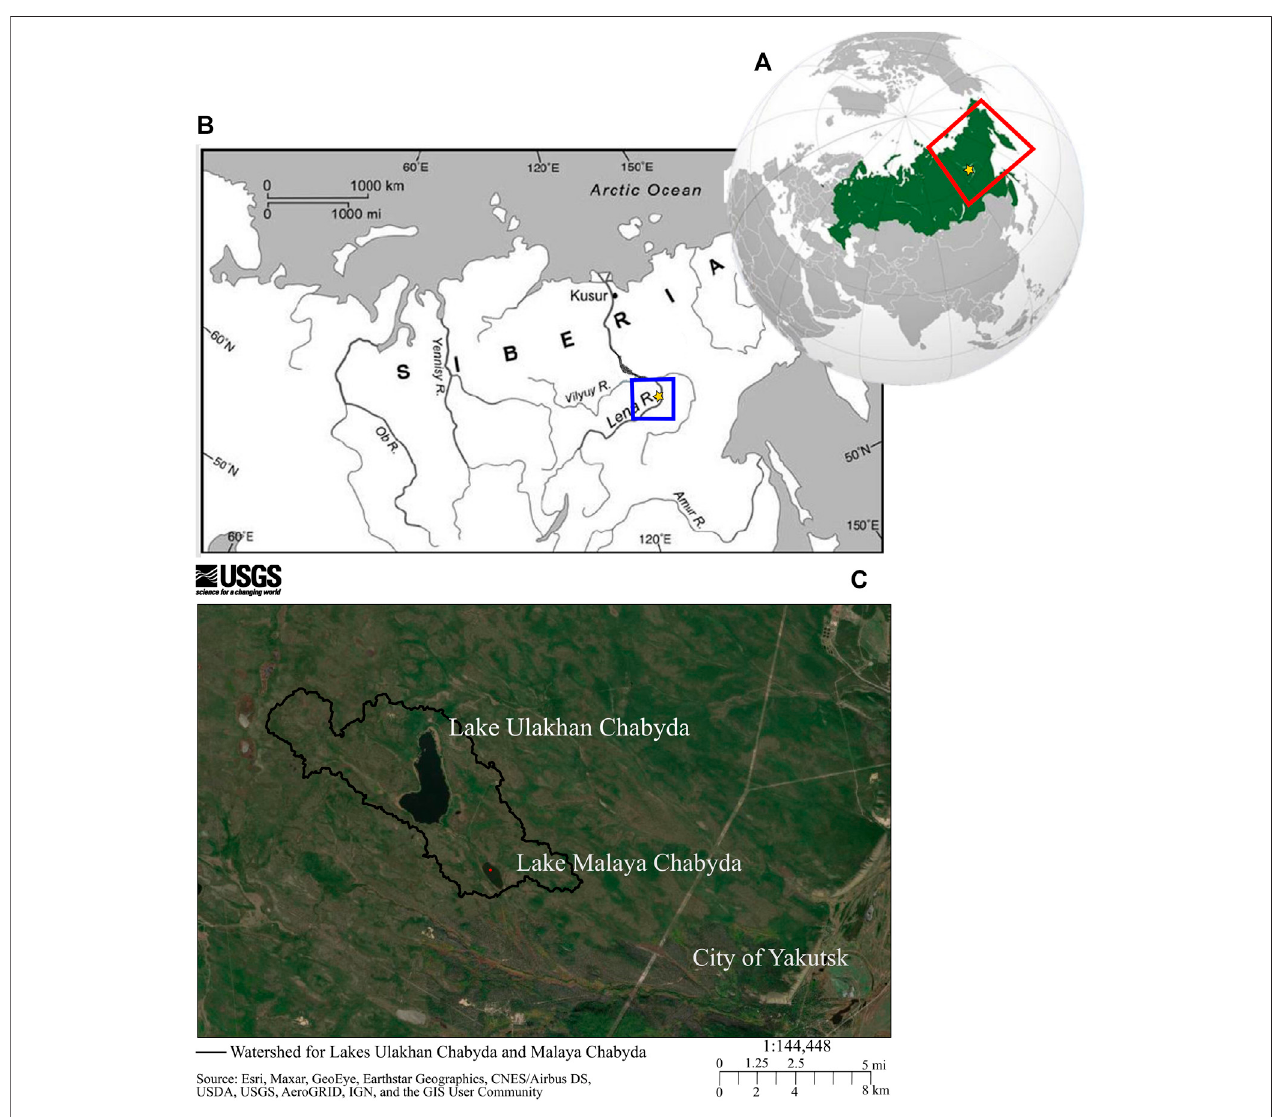
FIGURE 1 | (A) Map showing general location of the study site (red box) within the Russia Federation (green) (B) Location of study site (blue box). Note the Lena River and the city of Yakutsk (yellow star) (C) Locations of Lakes Ulakhan Chabyda and Malaya Chabyda, near the city of Yakutsk. Lake catchment is outline in black. Coring site location is indicated by red